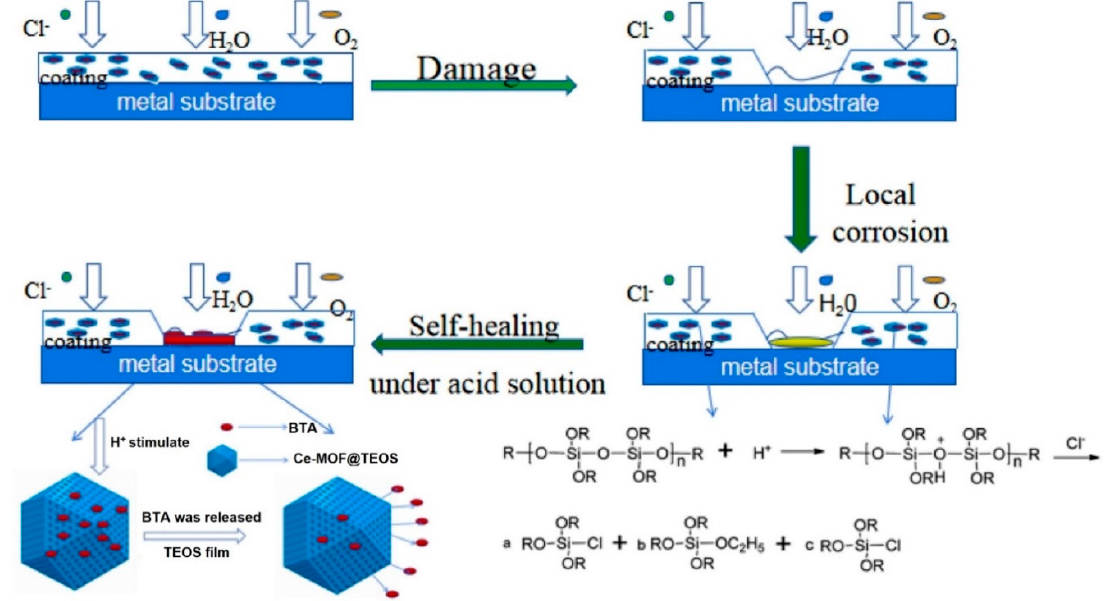
Figure 5. Schematic of the self-healing mechanism of the corrosion inhibitor encapsulated MOF/epoxy coatings [83] .